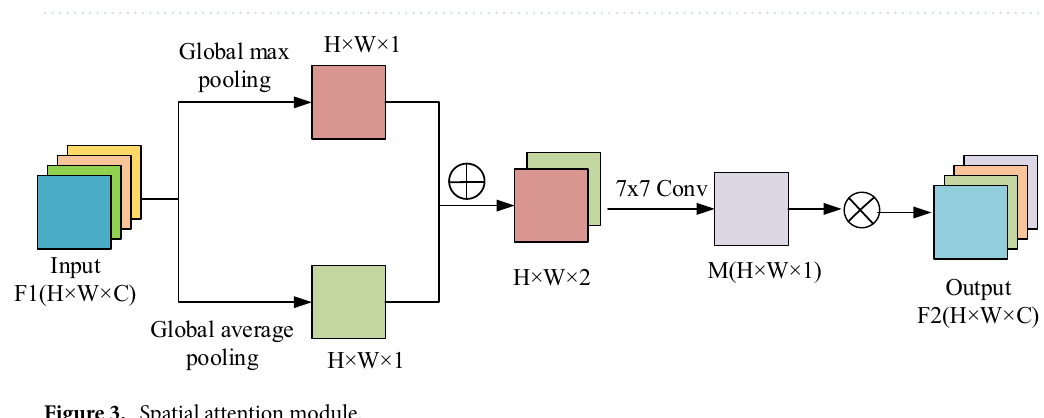
Figure 3. Spatial attention